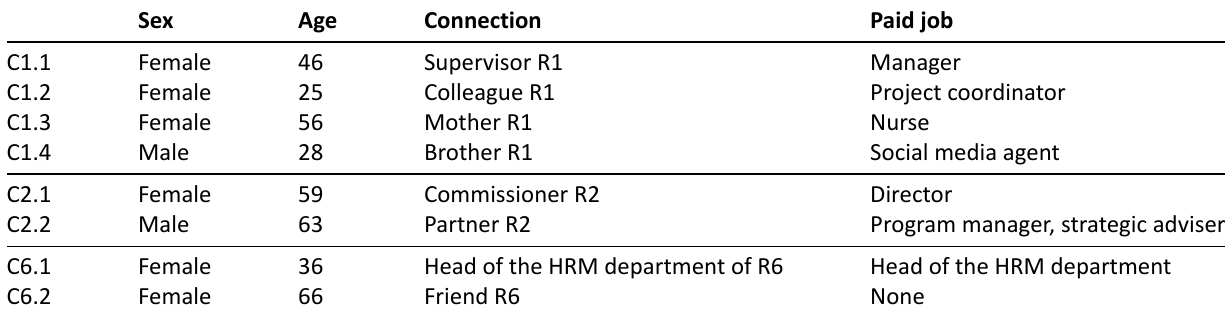
Table 2. Demographic information about the participants who were part of the private and professional network of the interviewees with a work-relevant